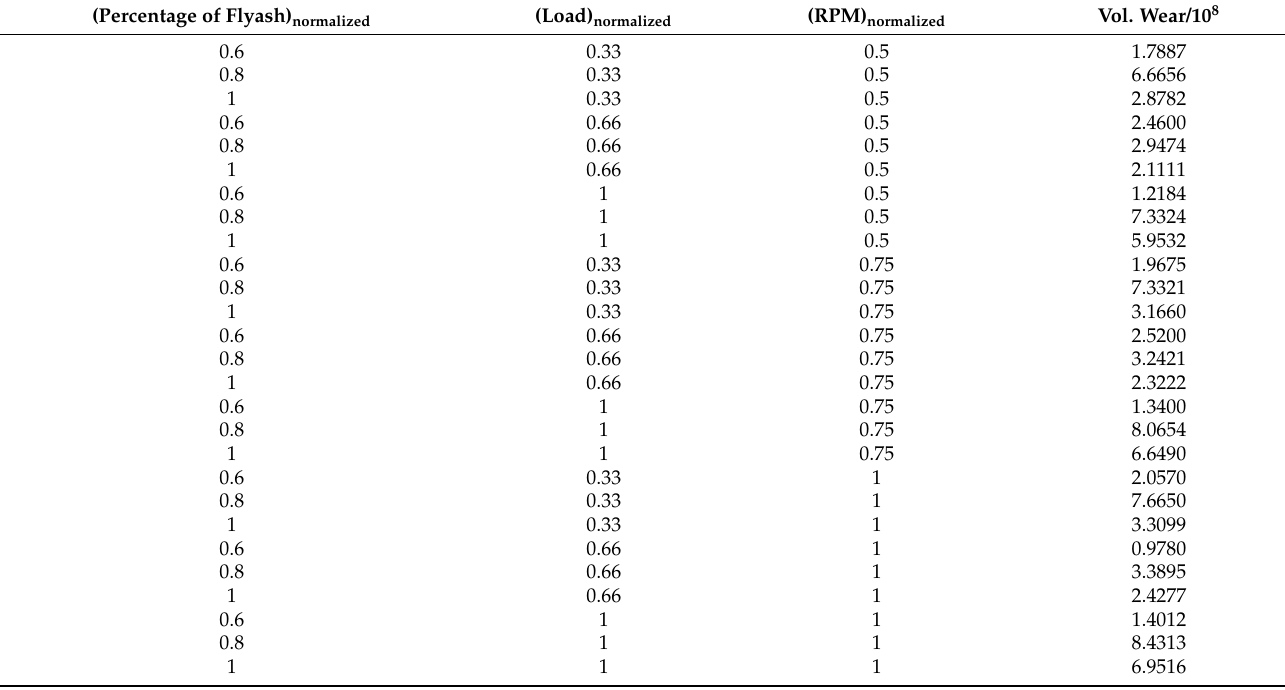
Table 6. Normalized values of Experimental